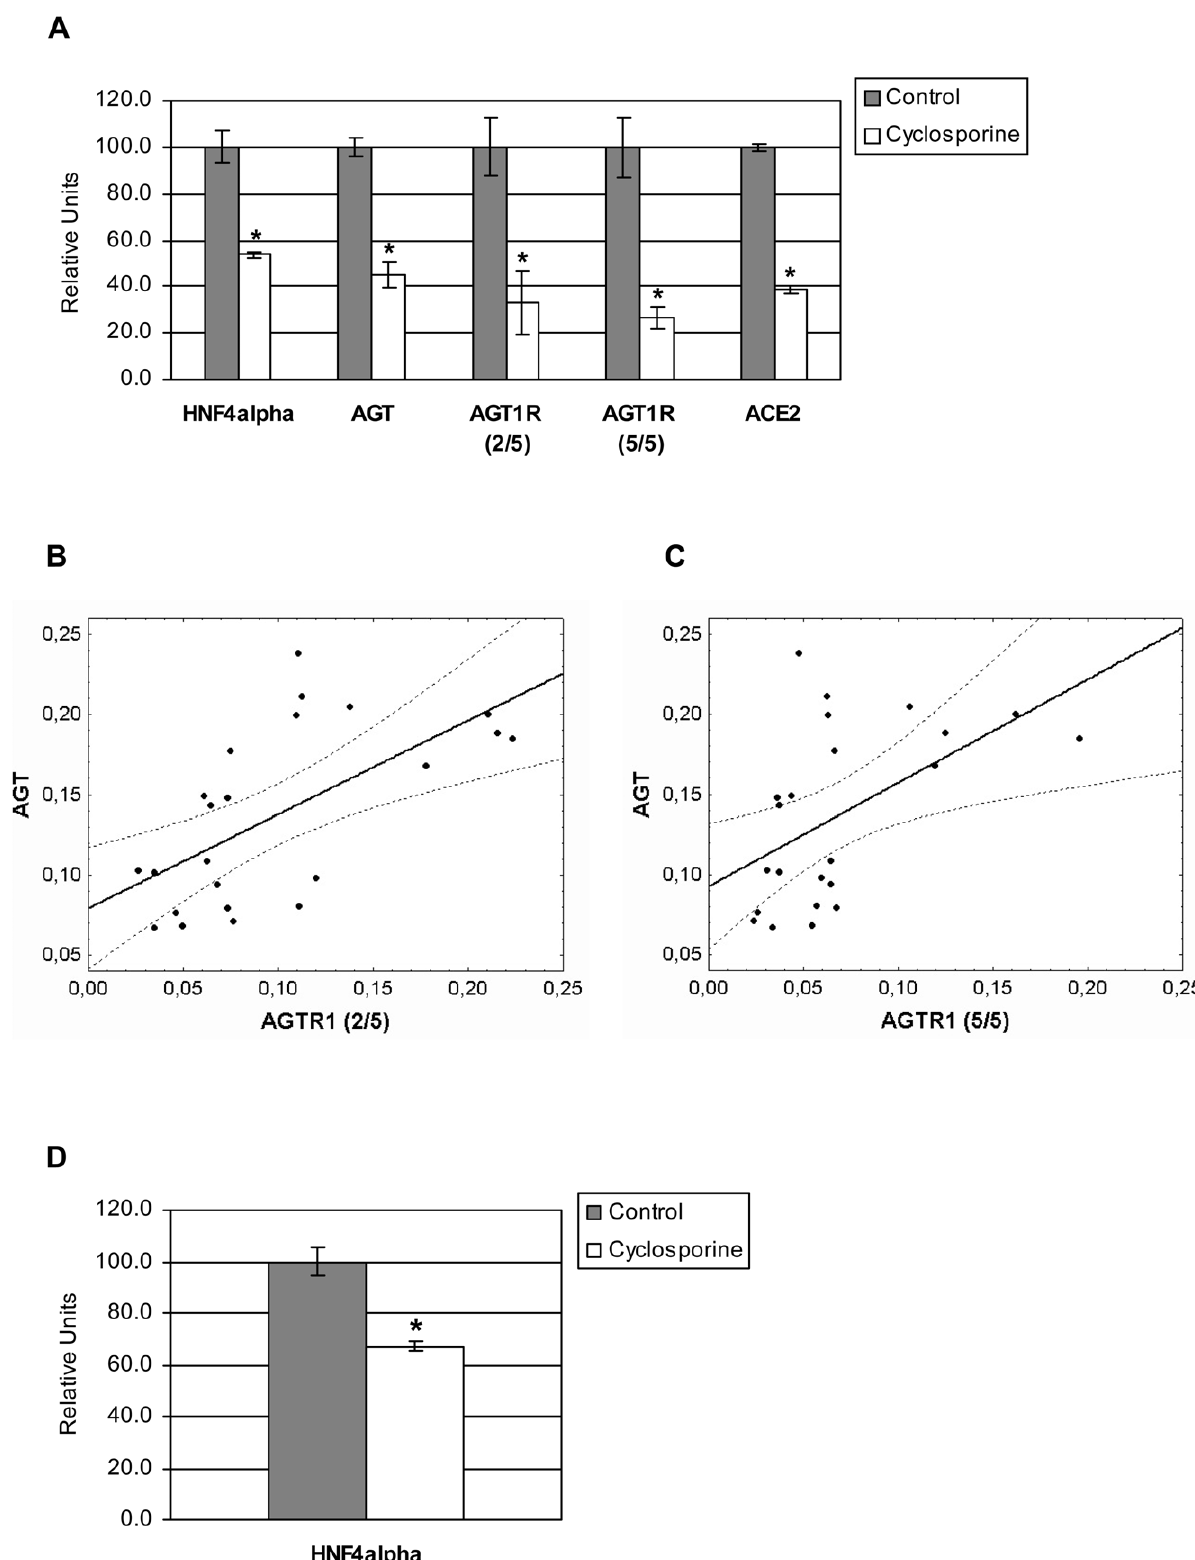
Figure 1. Regulation of gene expression in HepG2 cells after cyclosporine treatment. A. Gene expression was measured by quantitative real-time RT-PCR in HepG2 cells 72 h after treatment with 10 m g/ml cyclosporine (n=3, respectively) and was determined relative to expression of mitATPase6, which served as a housekeeping gene. Gene expression in untreated HepG2 cells was set to 100 and values for cyclosporine treatment represent transcript abundance relative to control. Non-parametric Mann-Whitney-U-Test was used to compare cyclosporine treated and control